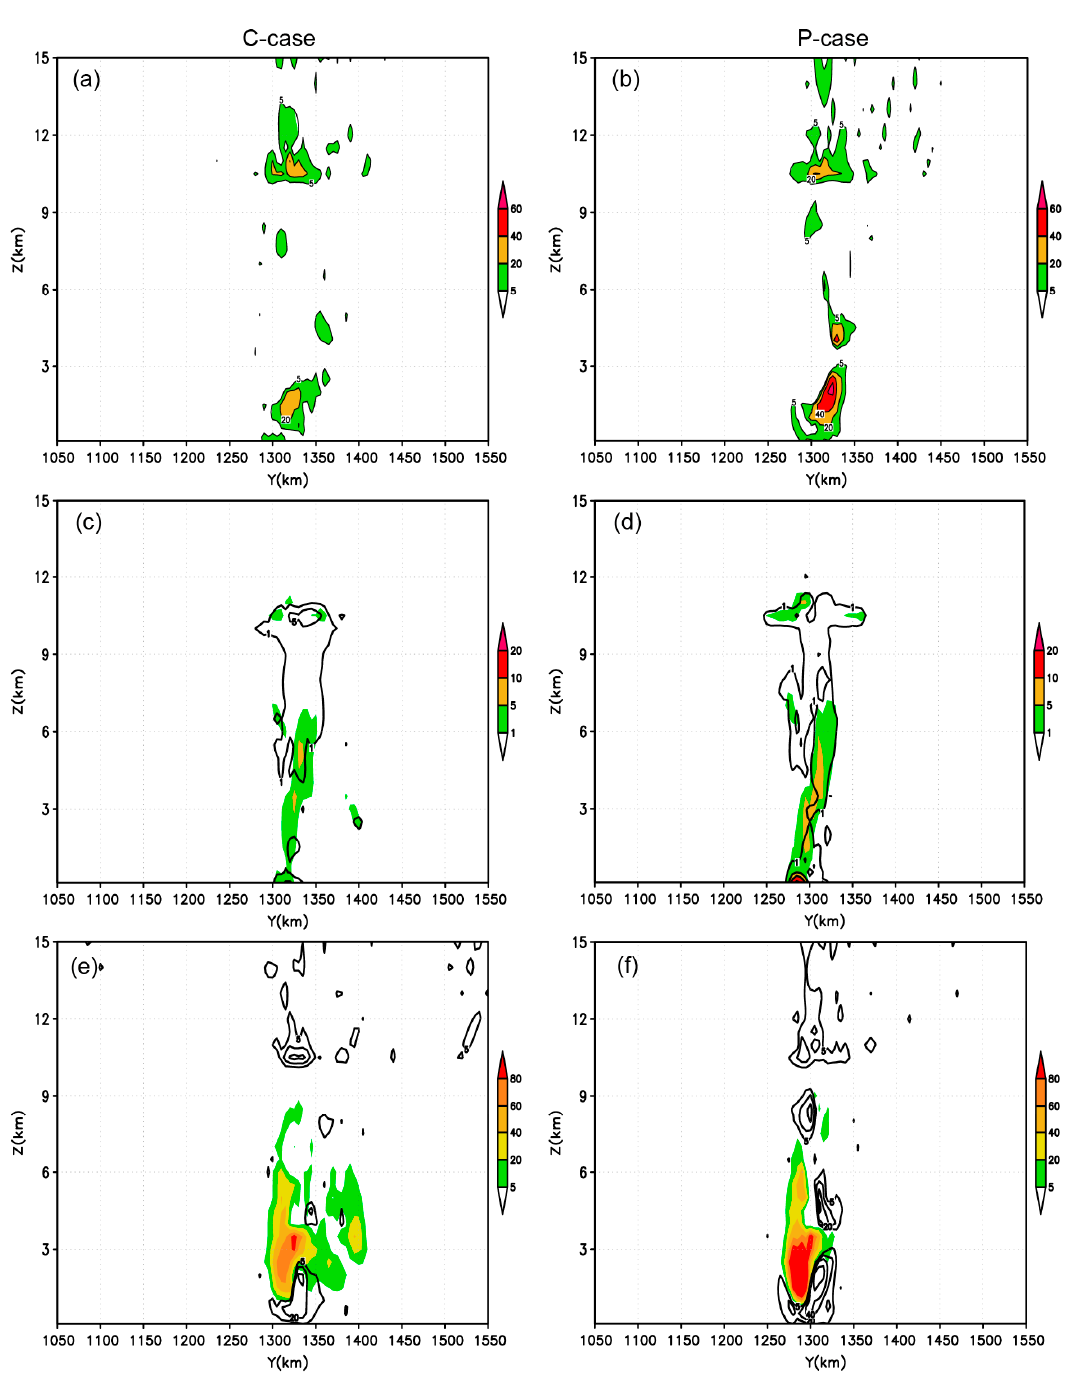
Figure 14. Vertical cross sections of zonal mean frontogenesis function at t = 21 h (Units: 1 k / 100 km · h − 1 ) ( a , b ) F ; ( c , d ) F 1 (shading) and F 2 (contour); ( e , f ) F 3 (contour) and F 4 (shading). F represents the frontogenesis function; F 1 , F 2 , F 3 , and F 4 represent horizontal divergence term, horizontal deformation term, tilting term, and diabatic heating term, respectively. The left panels show C-case, the right panels show